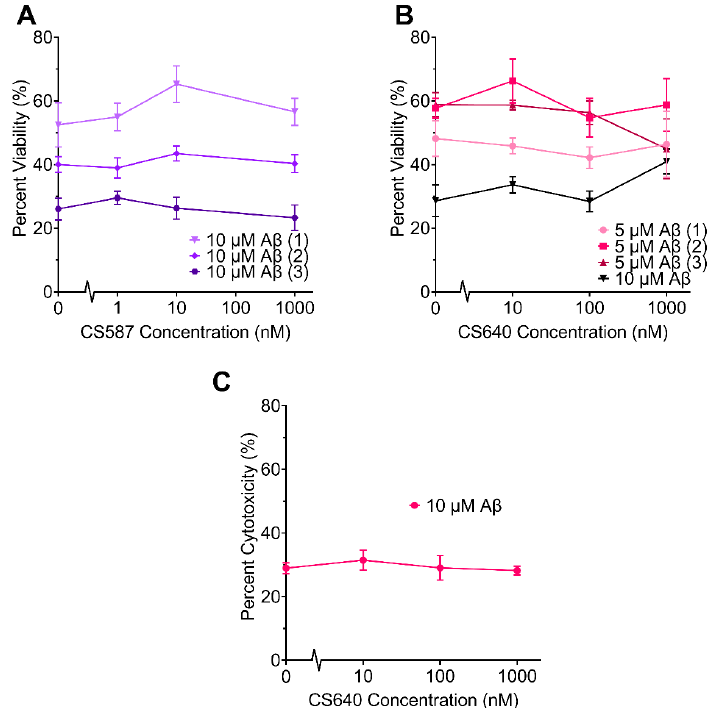
Figure 5. Effect of varying concentrations of CaMK1D inhibitors on the viability of primary neurons treated with A β 1–42 oligomers. Viability of mouse primary cortical neurons was measured by MTT assay. The response from cells treated with no CaMK1D inhibitors or A β 1–42 was normalized to 100% viability (shown in Figure 3). Trial numbers are indicated in parentheses. ( A ) Results of three separate MTT assay trials using CS587 and 10 µM A β 1–42 . ( B ) Results of three separate MTT assay trials using CS640 and 5 µM A β 1–42 , as well as one trial using 10 µM A β 1–42 . ( C ) Results of one LDH assay trial with CS640 and 10 µM A β 1–42 . Points represent the mean of six replicates, and error bars represent standard deviation.